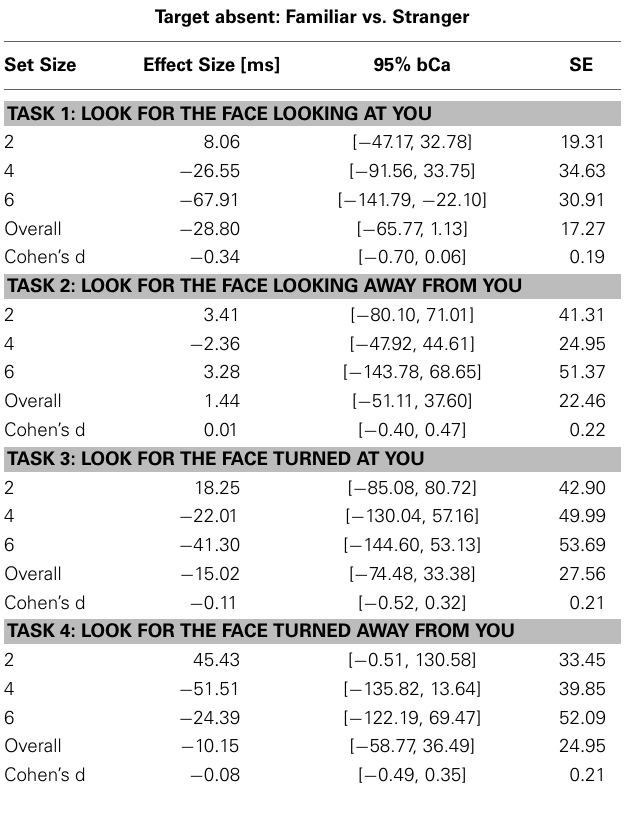
Absent conditions and Cohen’s d effect size of familiarity across set sizes in the four tasks (bCa bias-corrected and accelerated confidence intervals, computed with 10,000 repetitions).